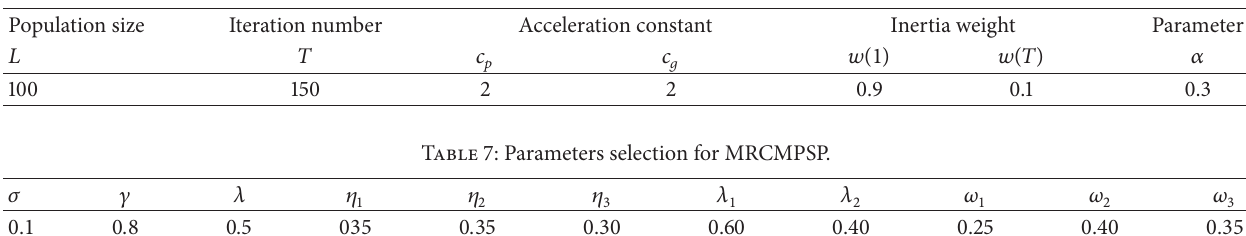
Table 6: Parameters selection for the proposed CP-based HPSO.